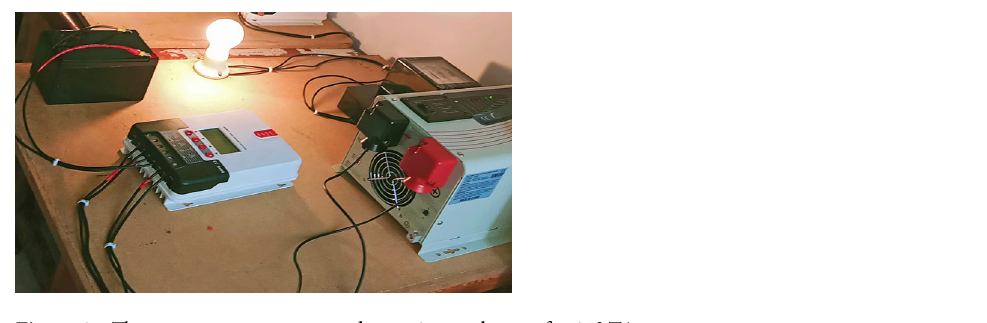
Figure 9. The system components and experimental setup for 25°